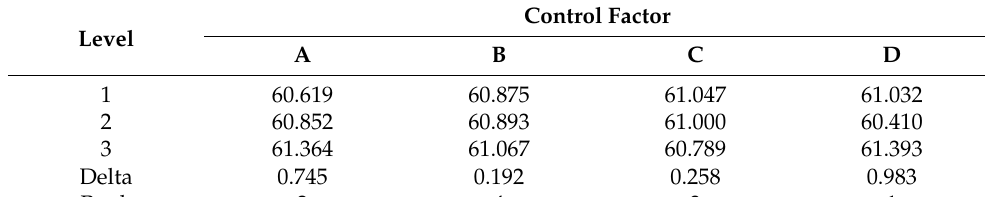
Table 5. Response table for the S/N ratios.